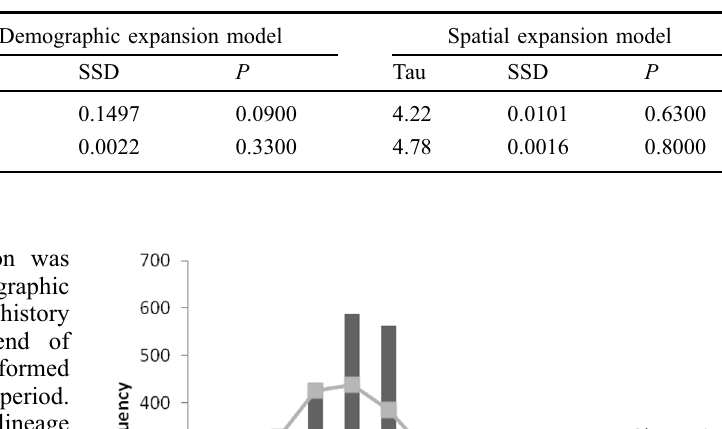
Table 4. Parameters of mismatch distribution analysis.